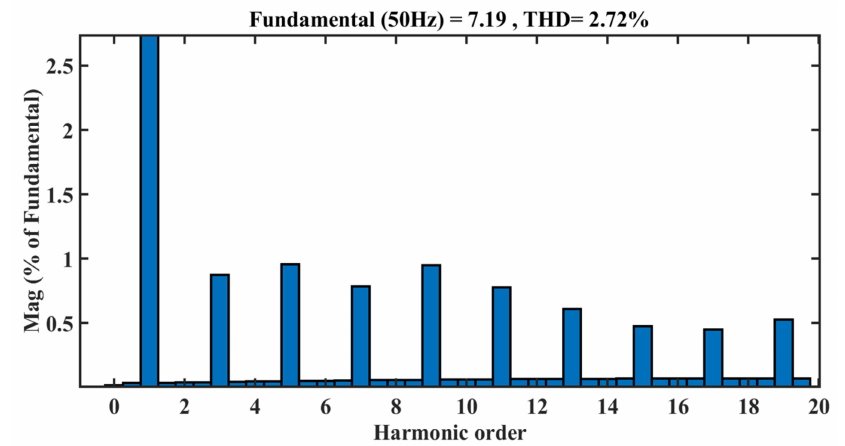
Figure 18. THD analysis of grid current waveform with HHO-PI